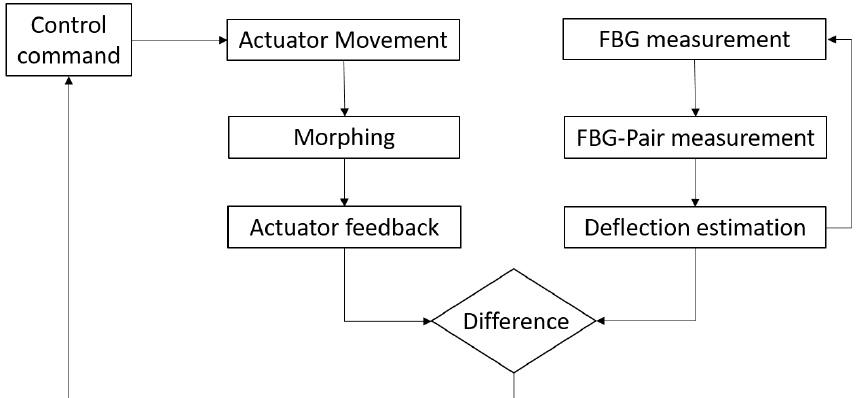
Figure 6. Block diagram depicting the sequential workflow of the